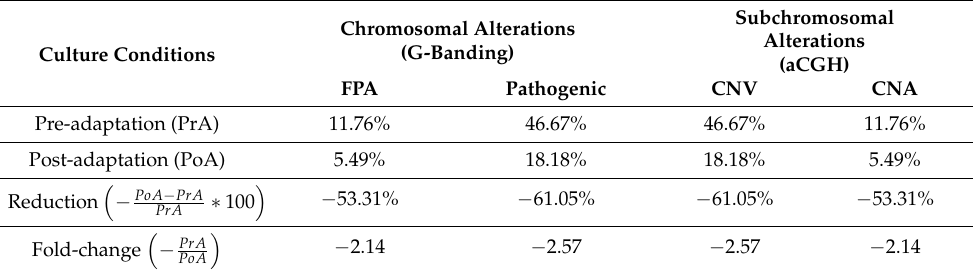
Table 5. Prevalence of chromosomal and subchromosomal alterations detected by G-banding and aCGH, respectively, in pre- and post-adaptation hPSC lines. The reduction in the prevalence of each de novo alteration time in the post-adaptation (PoA) group compared to the pre-adaptation (PrA) group is showed, as well as the fold-change.